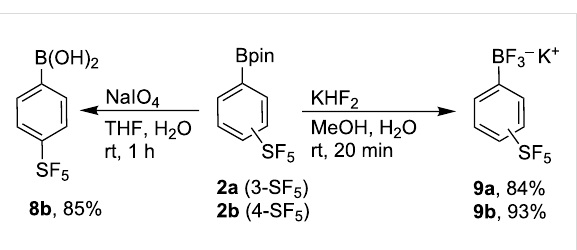
Scheme 5: Syntesis of boronic acid 8b and trifluoroborates 9 . Reac- tion conditions for the synthesis of 8b : 2 (2 mmol), NaIO 4 (8 mmol), THF (8 mL), H 2 O (2 mL), rt, 1 h. Reaction conditions for the synthesis of 9 : 2 (2 mmol), KHF 2 (10 mmol), MeOH (8 mL), H 2 O (3.6 mL), rt, 20